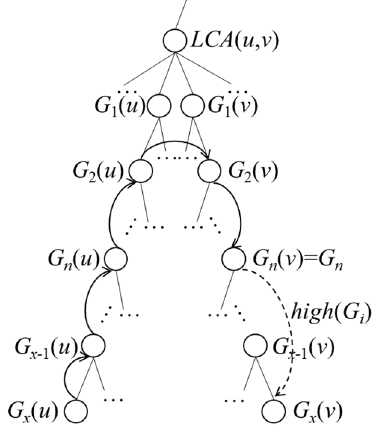
Figure 8. Case 1 of highDist ( G i , u ).